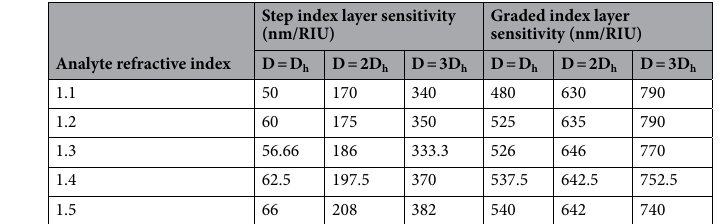
Table 3. Sensitivity comparison of SI-PhCR and EG-PhCR Structure with different defect layer thickness at a 20° incidence angle.